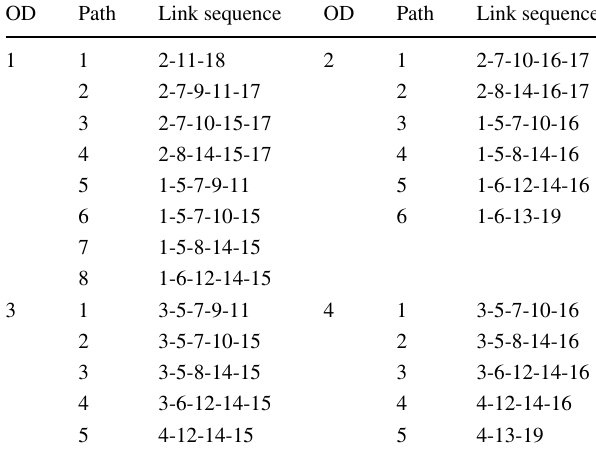
Table 7 List of paths for the Nguyen-Dupuis network OD Path